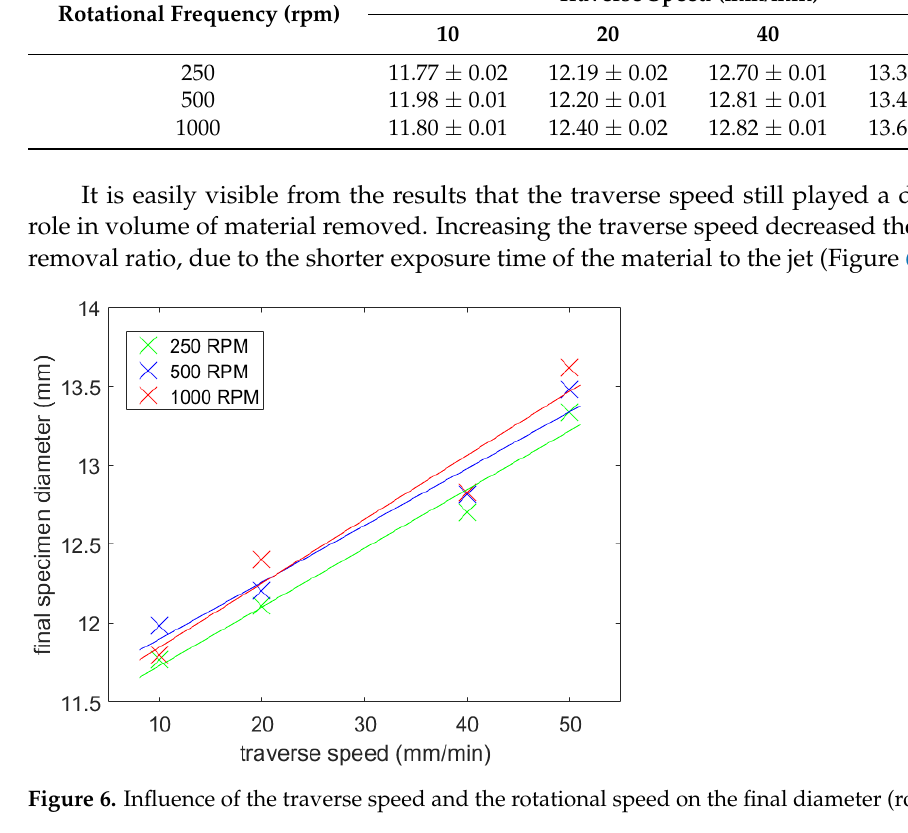
Figure 7. Influence of the traverse speed and the rotational speed on the final diameter (square rod). It can only be estimated whether increasing rotational speed also increases the result- ing sample diameter, and thus lowers the volume of the material removed. This phenom- enon is partially visible in both figures: Figures 6 and 7. However, it is obvious that the impact of the rotational speed of the specimen on the material volume removed was low. This may have been caused by the type of material selected. It is generally harder to ob- serve slightly changed conditions in high strength materials, such as steel. Since several lateral shifts were performed, we still lacked information about how much material was eroded during each jet shift. Investigation of Volume Removed for Different Lateral Jet Shifts